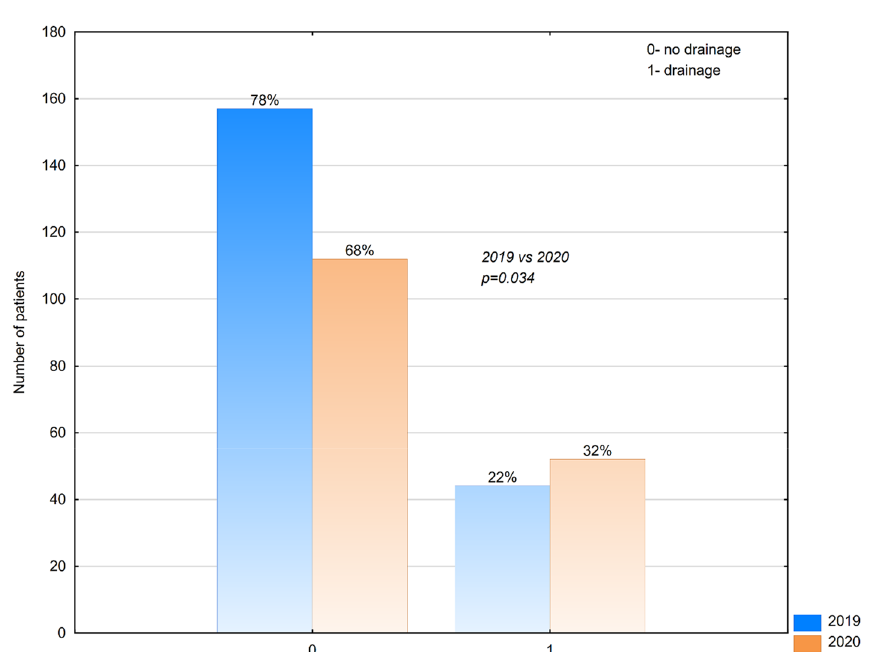
Figure 5. The amount of cases threated with appendectomy and drainage in 2019 and